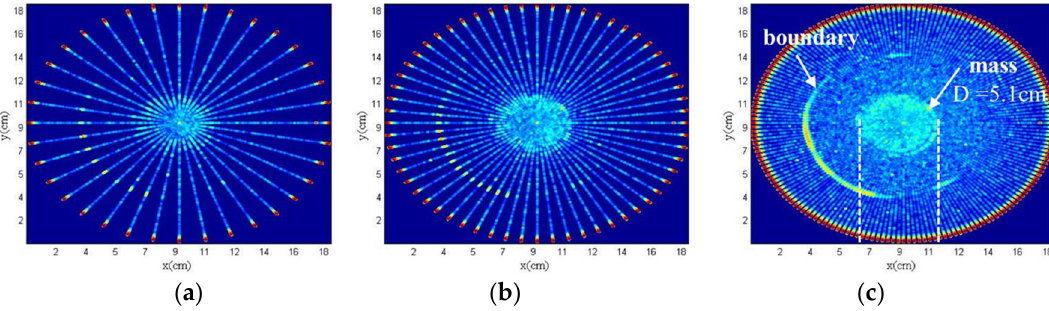
Figure 10. Ultrasonic tomography of breast model using the ring system with an ( a ) angle of 10°; ( b ) angle of 6°; ( c ) angle of 2°.